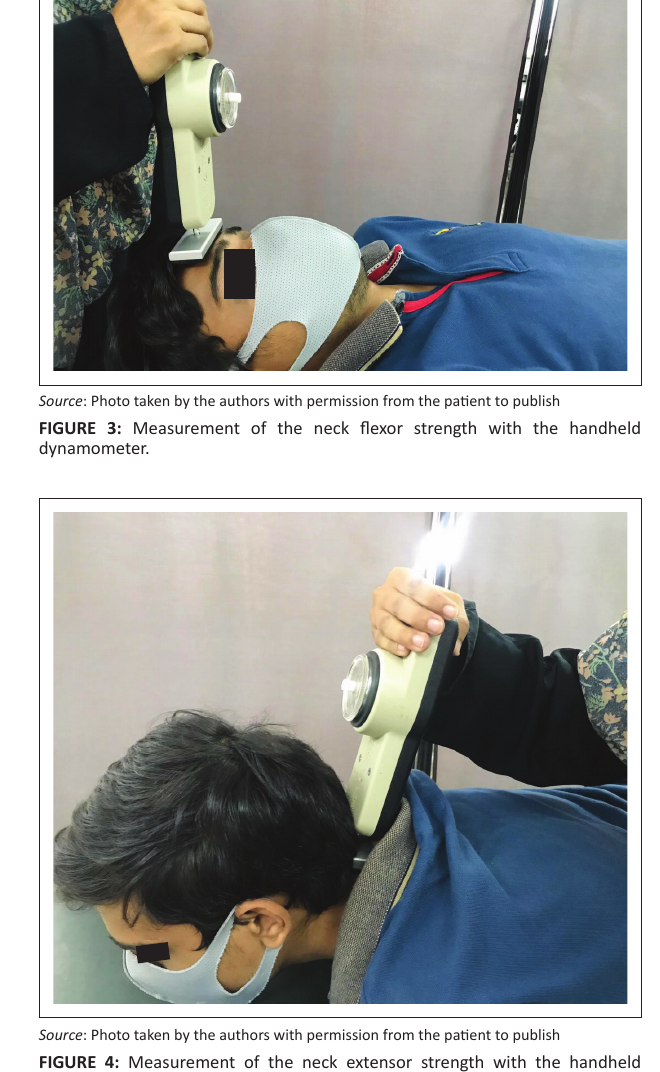
FIGURE 2: The craniocervical flexion test to measure endurance.